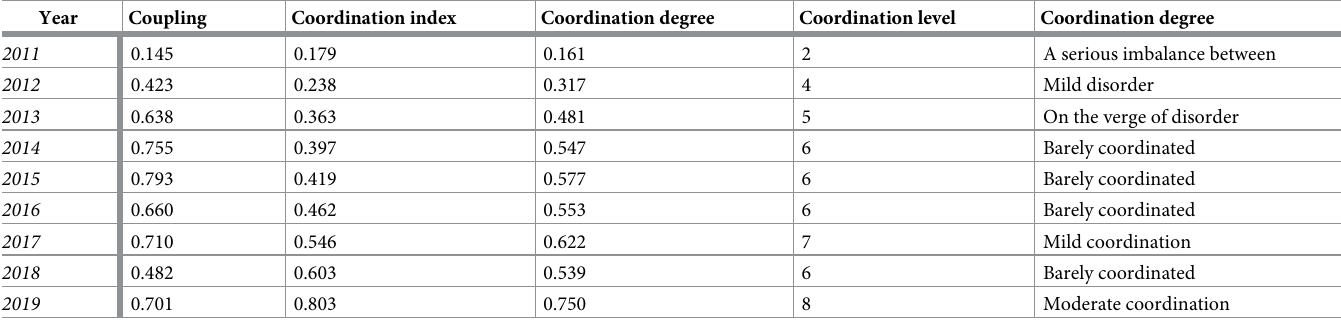
Table 7. Level of coupling degree and coordination degree in Shandong Province.